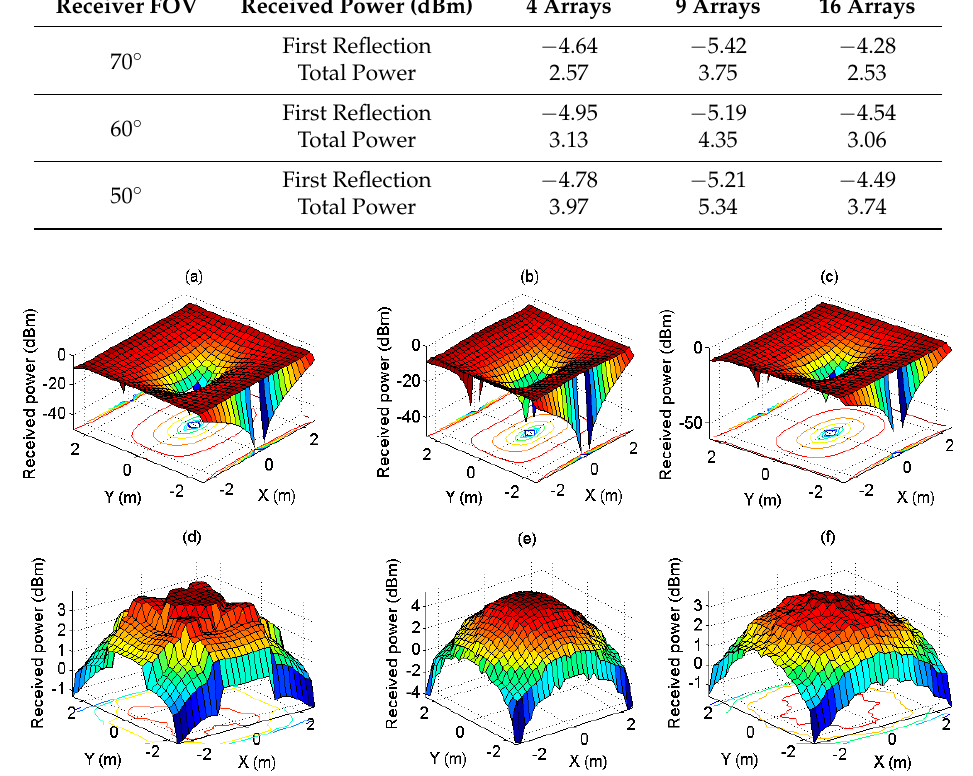
Figure 3. The first reflection path received power (dBm) at field-of-view (FOV) = 50° for ( a ) the 4 arrays model, ( b ) the 9 arrays model, and ( c ) 16 arrays model. Total received power (dBm) for ( d ) the 4 arrays model, ( e ) the 9 arrays model, and ( f ) the 16 arrays model. Table 3. Maximum power received after changing the FOV.